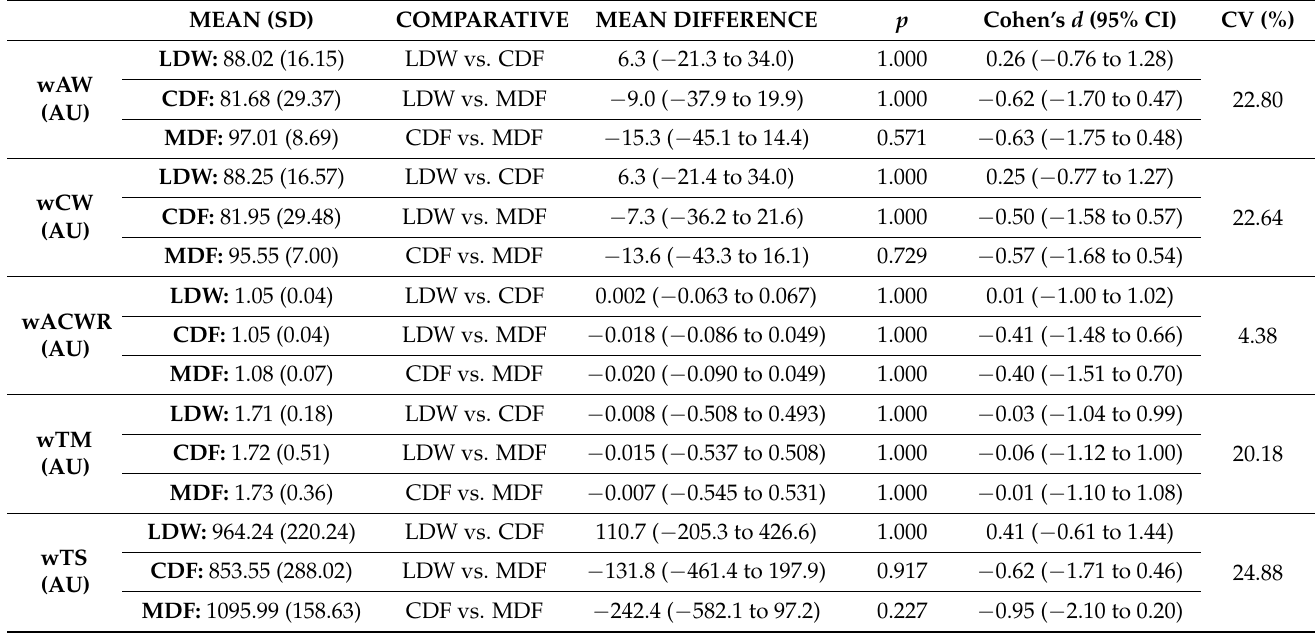
Table 2. Between-group differences in the full season weekly average for workload variables, training monotony, and training strain.